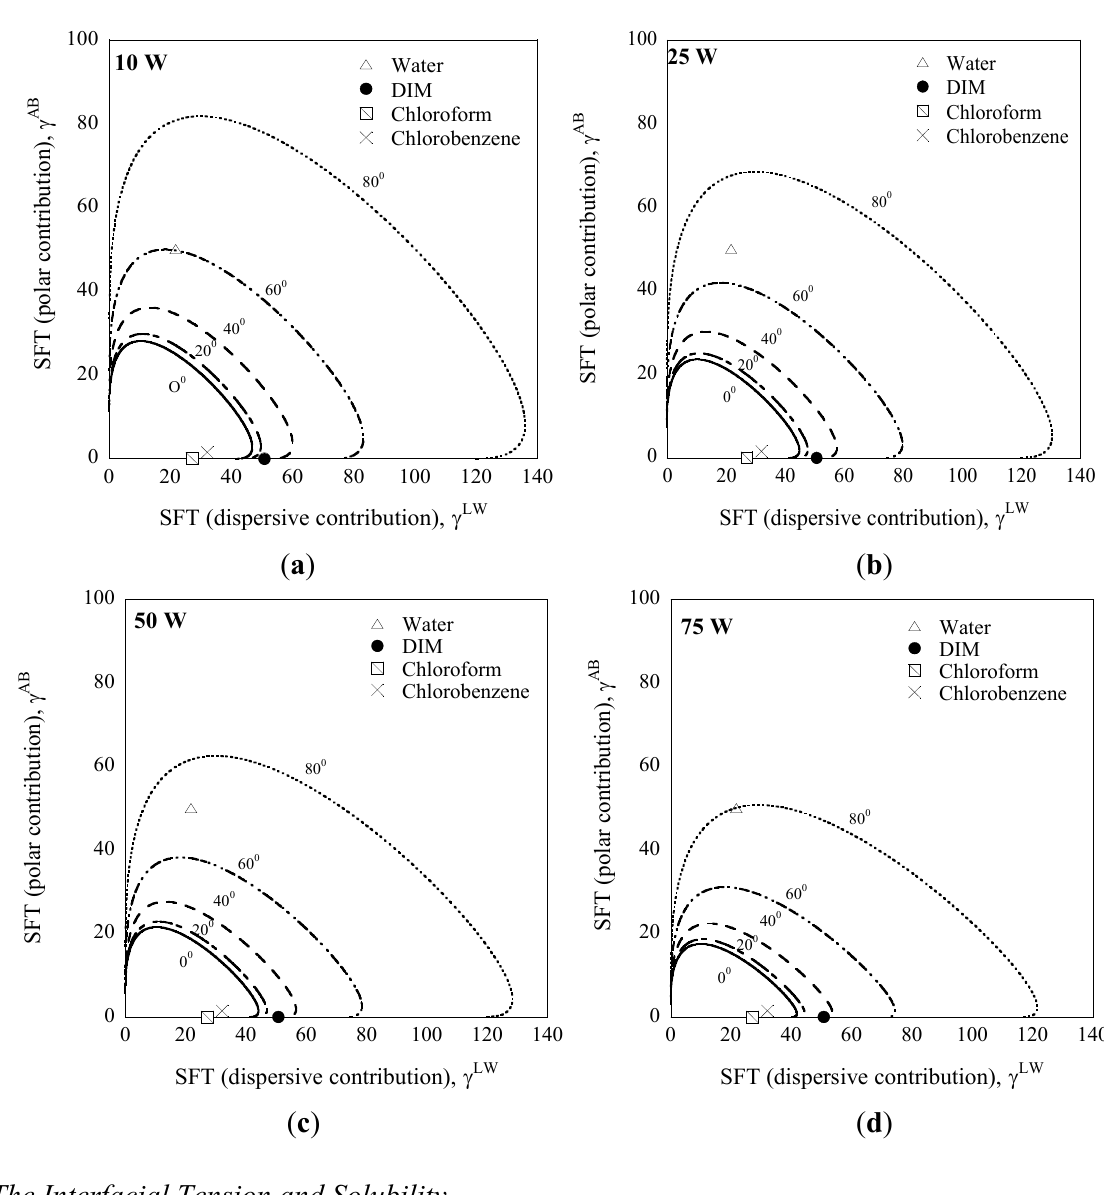
Figure 8. Wetting envelopes at 0°, 20°, 40°, 60° and 80° using surface tension components for pp–GT samples fabricated at ( a ) 10 W; ( b ) 25 W; ( c ) 50 W and ( d ) 75